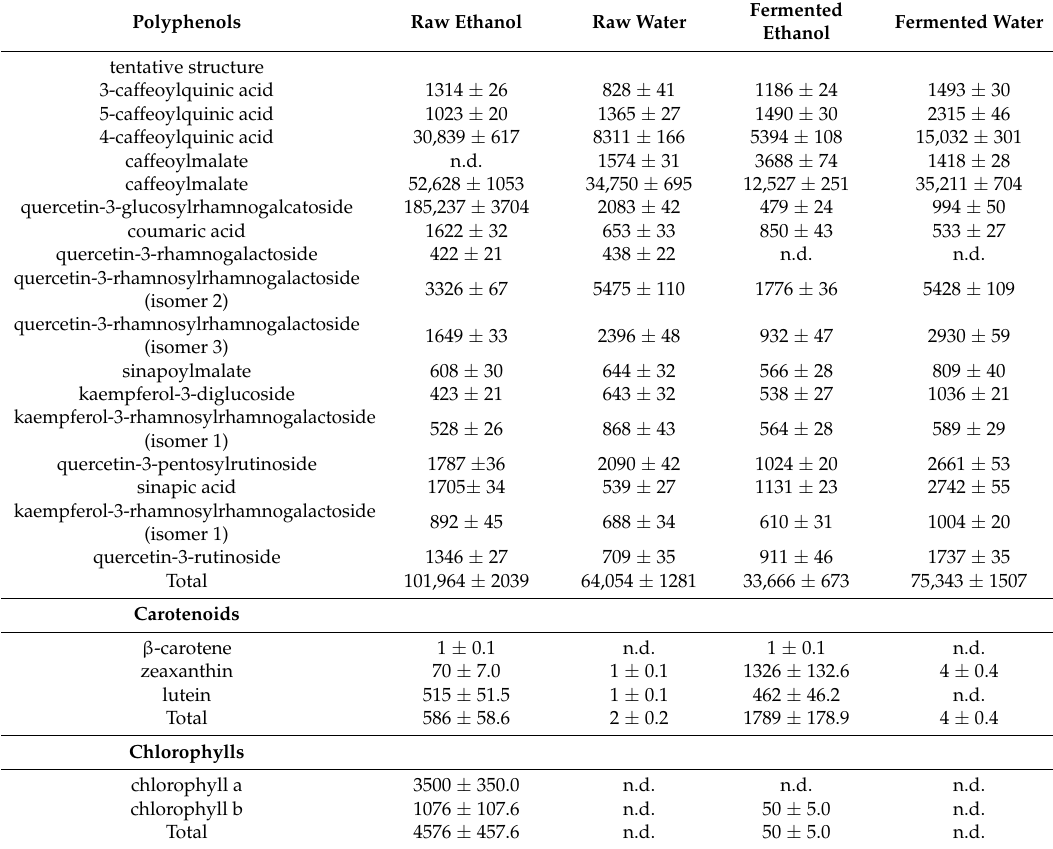
Table 1. Phytochemical content in the extracts of raw vs. fermented S. scabrum in µ g/g DM (location A). The data are presented as phytochemical content ± average analytical